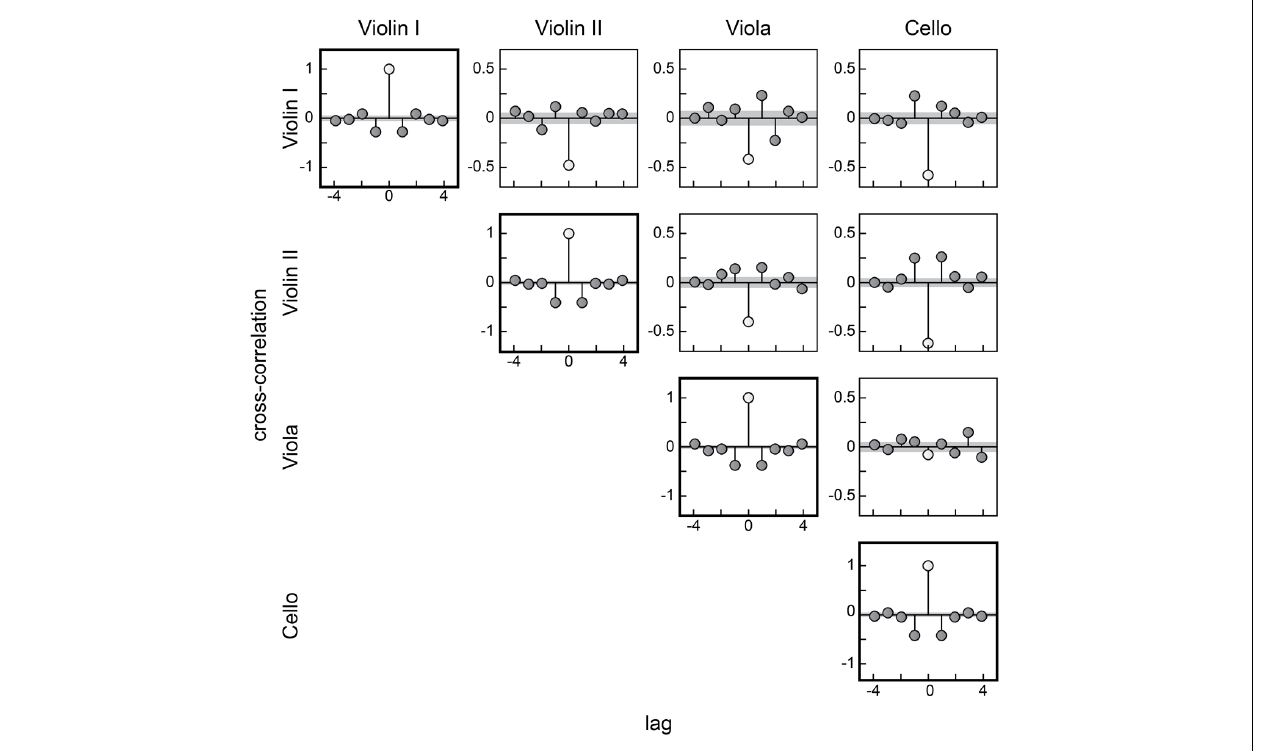
FIGURE 3 |A matrix of cross-correlation coefficients of IBIs between performers. In the diagonal axis (bold squares), the autocorrelations are shown. Shaded areas indicate one standard error.